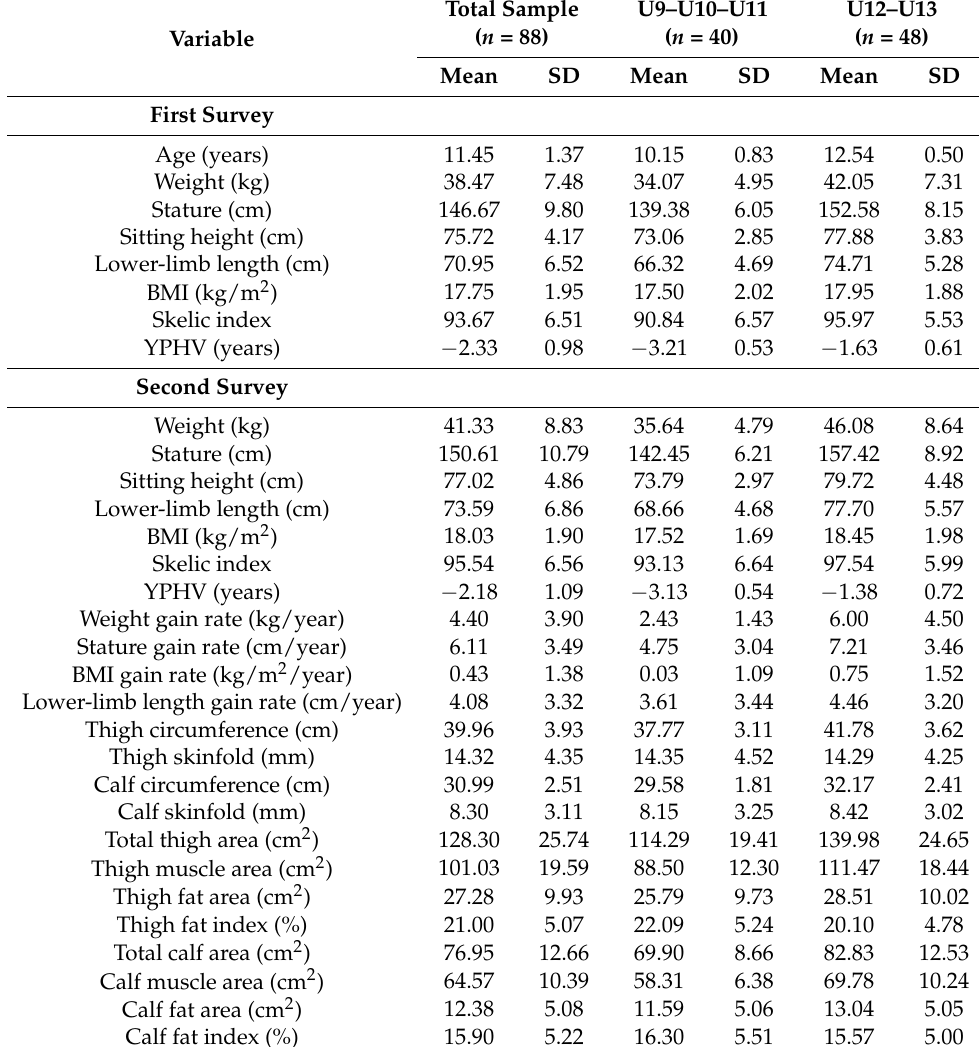
Table 1. Anthropometric characteristics (mean and SD) for the total sample and age subgroups of elite soccer players during the first (above) and second (below)